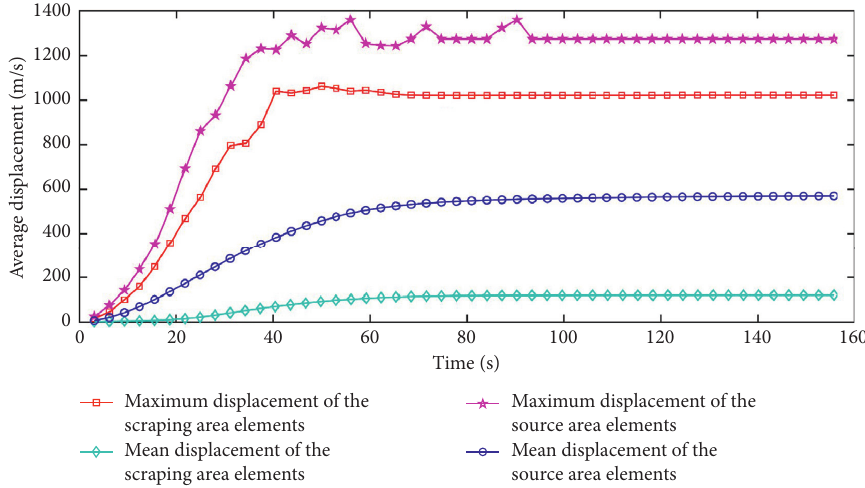
Figure 8: Curve of average displacement of the source area and the scraping area